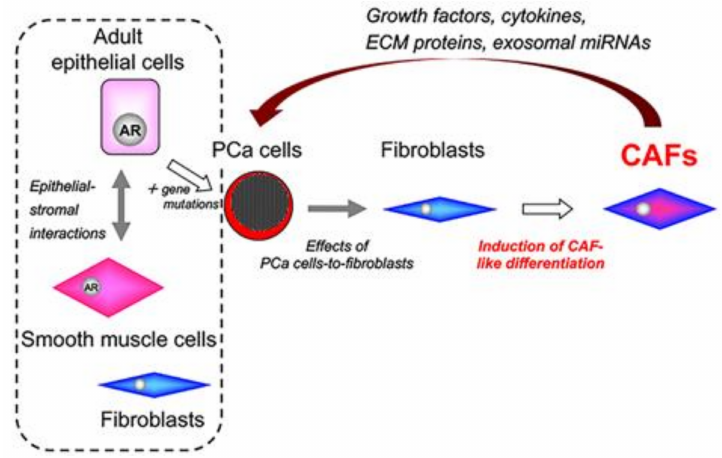
Figure 3. Induction of carcinoma-associated fibroblasts in the tumor stroma of prostate cancer. PCa cells induce CAF-like differentiation in normal fibroblasts. Importantly, heterogenous induction of CAF-like differentiation may be strongly dependent on the biochemical characteristics of PCa cells. AR: androgen receptor; CAFs: carcinoma-associated fibroblasts; PCa: prostate